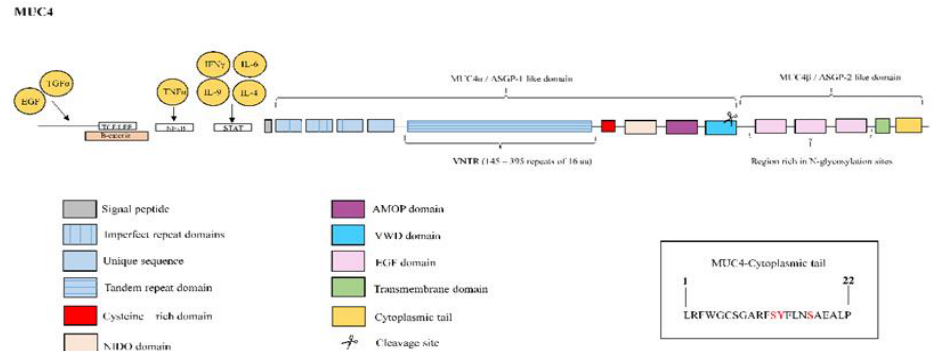
Figure 9. Structure of mucin MUC4. MUC4 protein is constituted by the ASGP-1-like extracellular domain or MUC4α, which contains an N-terminal signal sequence followed by: three imperfect repeats, an unique sequence, a variable number tandem repeat (VNTR) composed of 145 – 395 repeats of 16 amino acids, a cysteine-rich domain, nidogen-like domain (NIDO), adhesion-associated domain in MUC4 and other proteins (AMOP) and Von Willebrand factor type D domain (vWD). The cleavage site is located in this vWD domain. The ASGP-2- like or MUC4β subunit is rich in N-glycosylation sites and contains up to three EGF-like domains, a hydrophobic transmembrane region, and a 22-amino-acid cytoplasmic tail. The right box contains the amino acid sequence of the cytoplasmic tail with potential sites for phosphorylation marked in red color. MUC4 overexpression is induced by interleukin (IL)-9, IL-4 and IL-6 mediated JAK/STAT pathway activation. Combined treatment with tumour necrosis factor (TNF) α and interferon (IFN)- γ has been also shown to upregulate MUC4 expression through nuclear factor kappa B (NF- κB ) and JAK/STAT pathways respectively. The growth factors epidermal growth factor (EGF) and transforming growth factor α (TGα) also upregulate MUC4 expression . Three T-cell factor/lymphoid enhancer factor (TCF/LEF)-binding sites on the MUC4 promoter and the binding of β -catenin has been demonstrated on MUC4 promoter.